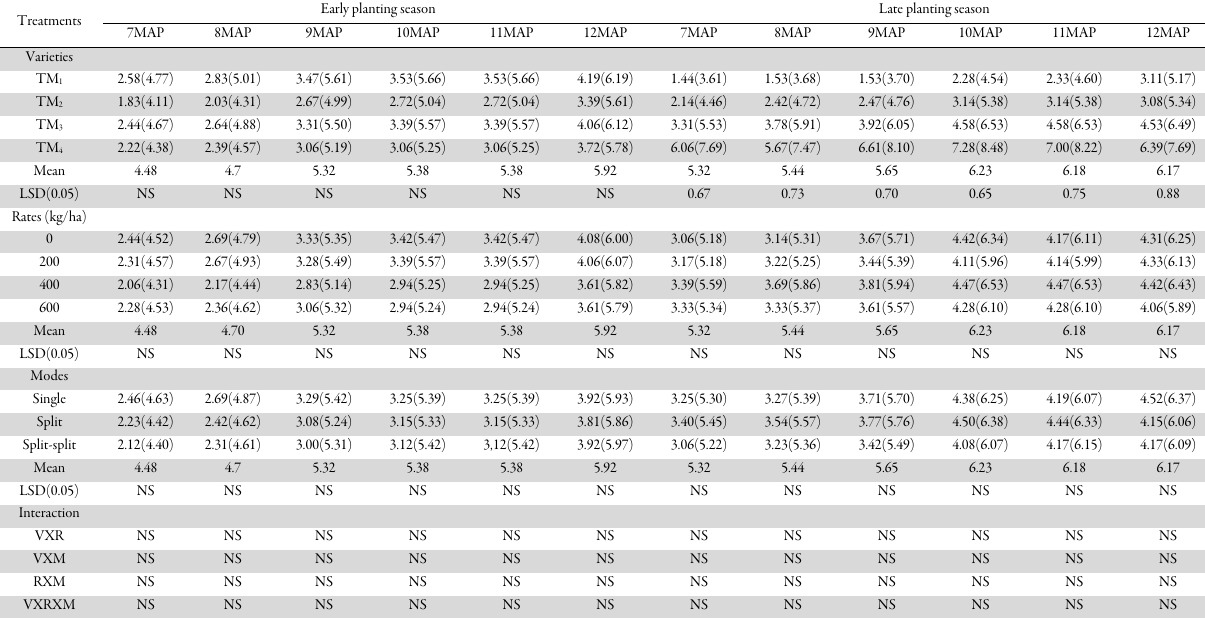
Table 7. Effect of varieties, rate, mode of NPK fertilizer and their interactions on the incidence of termites on the field Early planting Treatments